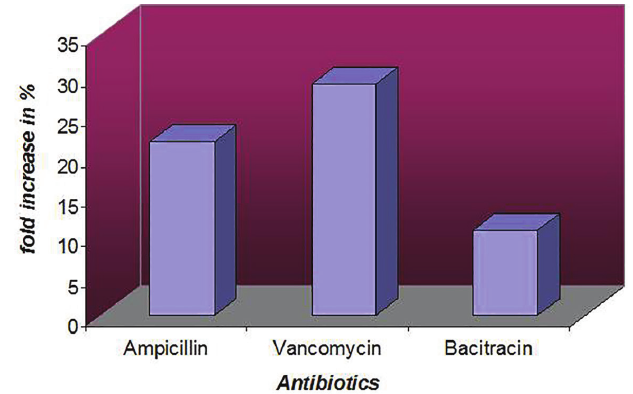
FIGURE 7 - Percentage fold increase in antibacterial activity of antibiotics and antibiotics with AgNPs.